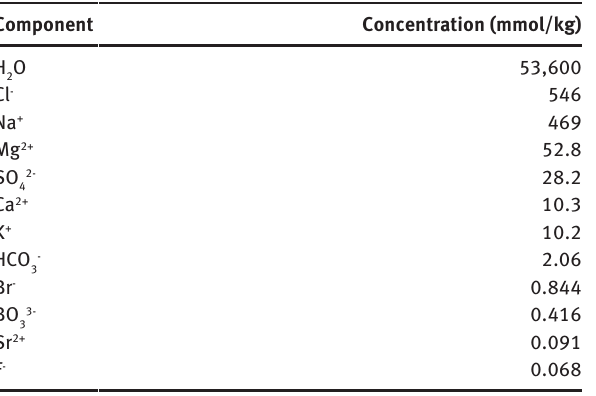
Table 1 Typical composition of seawater (salinity =